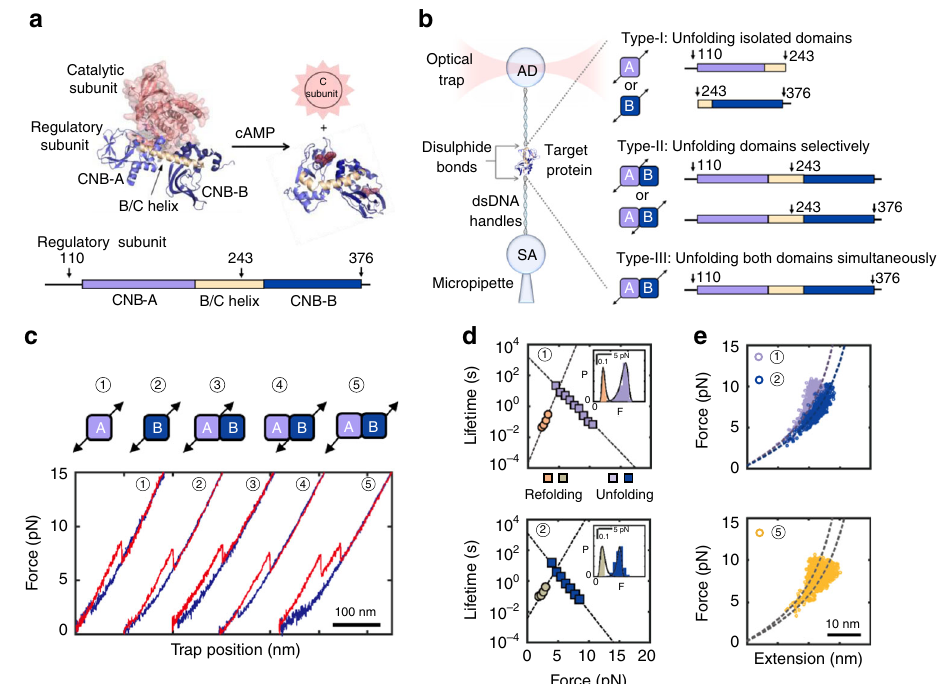
Fig. 1 Experimental design to study allosteric activation in PKA with optical tweezers. a Structure of the inactive PKA holoenzyme (left) 10 and active cAMP- bound regulatory subunit (right) 11 . The arrows on regulatory subunit domain organization indicate the residue positions for DNA handle attachment (bottom, arrows). Source data are provided as a Source Data fi le. b Schematic representation of optical tweezers assay (left) and protein constructs used in this study (right). c Force-extension curves for all pulling geometries in the apo state (unfolding in red; refolding in blue). Numbers match the pulling geometry with the unfolding and refolding trajectories. d Force-dependent folded-state lifetimes and unfolding force probability distribution (inset) in the apo state. Black lines in insets are the unfolding force distribution reconstructed from force-dependent lifetimes. e Worm-like chain (WLC) analysis of changes in extension vs. force for the isolated CNB domains (top) and for the fi rst and second unfolding rips from the type-III construct (bottom). Dashed lines are the WLC curves for the CNB-A (purple) and CNB-B domains (blue). Numbering in d and e is the same as in